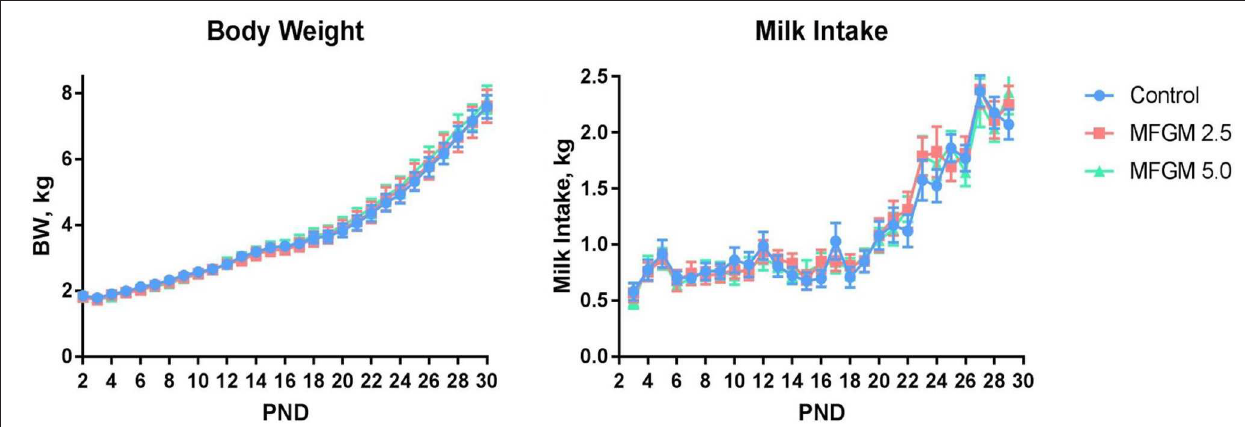
FIGURE 1 | Daily body weights and milk intake of pigs assigned to the control, MFGM-2.5, and MFGM-5.0 dietary treatments over the study duration (18 replicate pigs per treatment). PND 30 is not represented for body weight due to fasting prior to euthanasia. Likewise, milk intake for PND 30 and 31 are not represented, as piglets were fasted the night prior ahead of neuroimaging procedures. MFGM, milk fat globule membrane; PND, postnatal day.